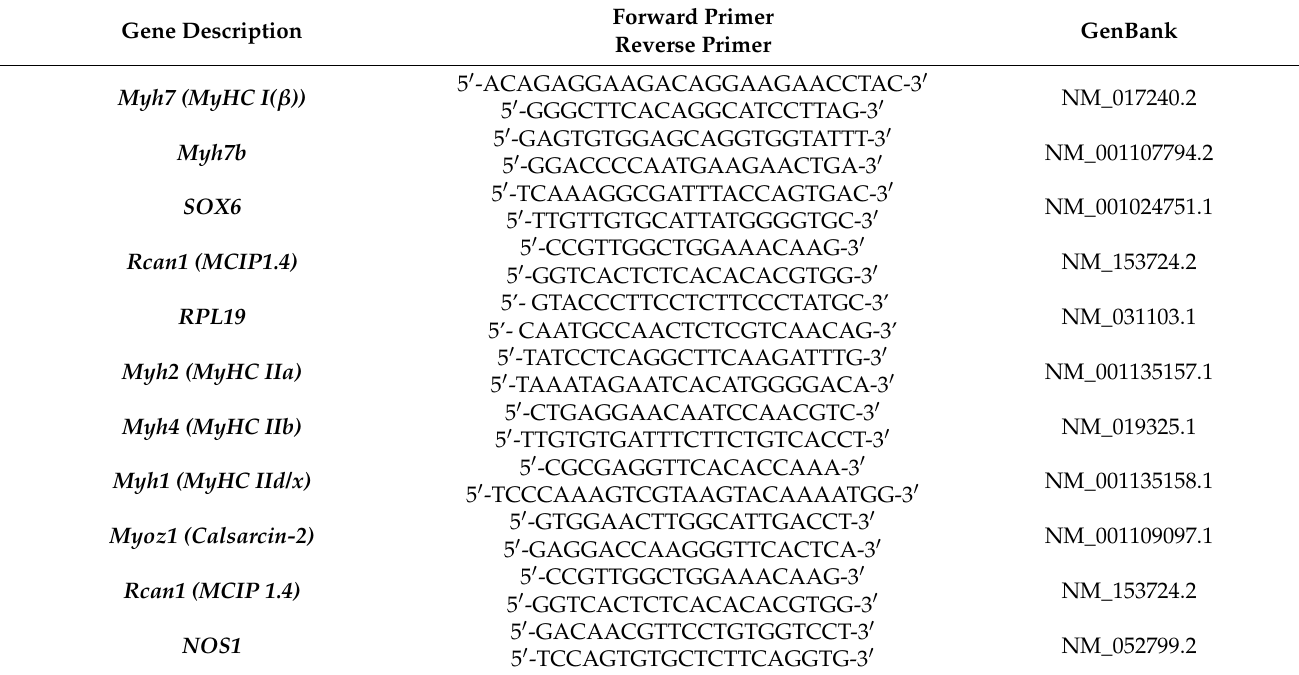
Table 2. Primers used for RT-PCR